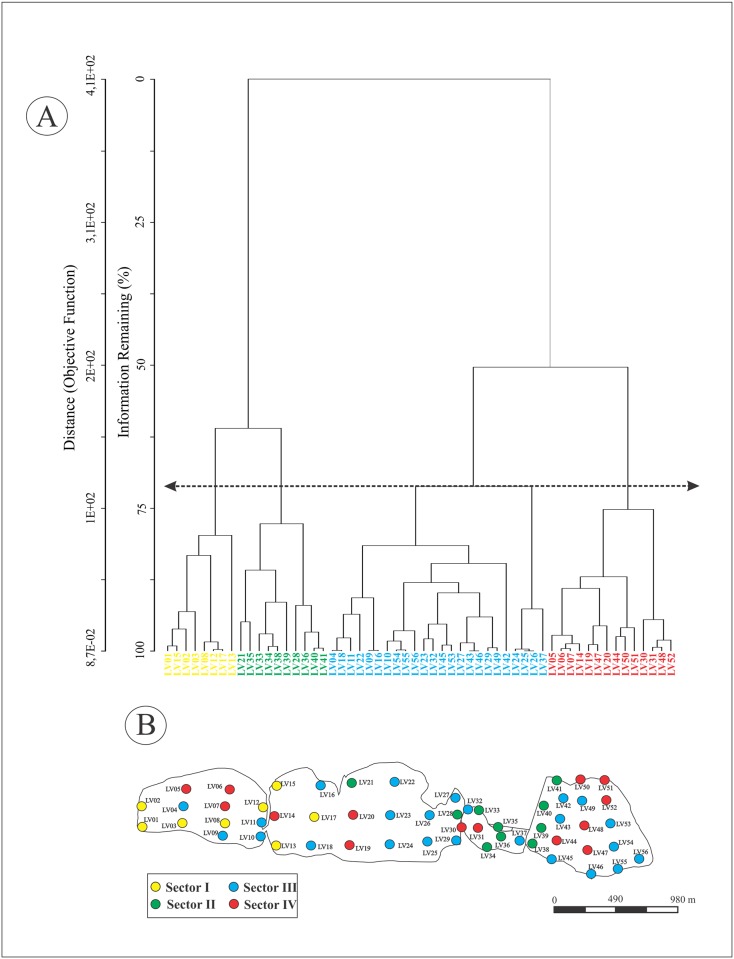
The cluster analysis results based on the physicochemical parameters and geochemical data.A) Cluster dendrogram plot relating the studied stations. B) Distribution map of the station groups identified through the cluster analysis at Vermelha Lagoon.